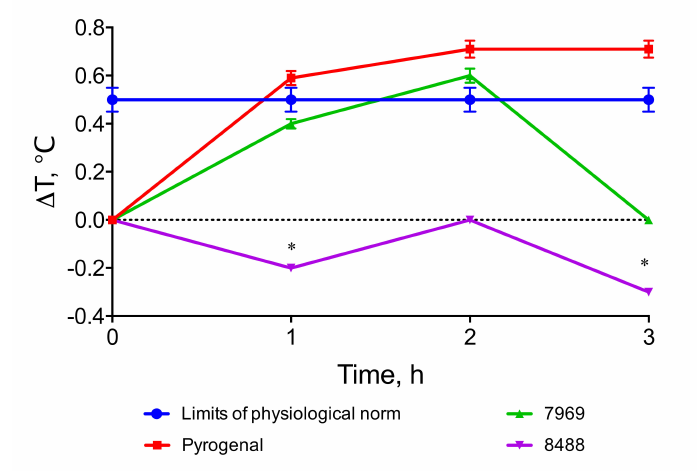
Figure 5. Pyrogenic e ff ect of P. agglomerans 8488 and 7969 LPSs. The time of the temperature measurements is indicated on the X-axis, and the temperature change between measurements on the Y-axis. * a significant di ff erence. Data are presented as means ±